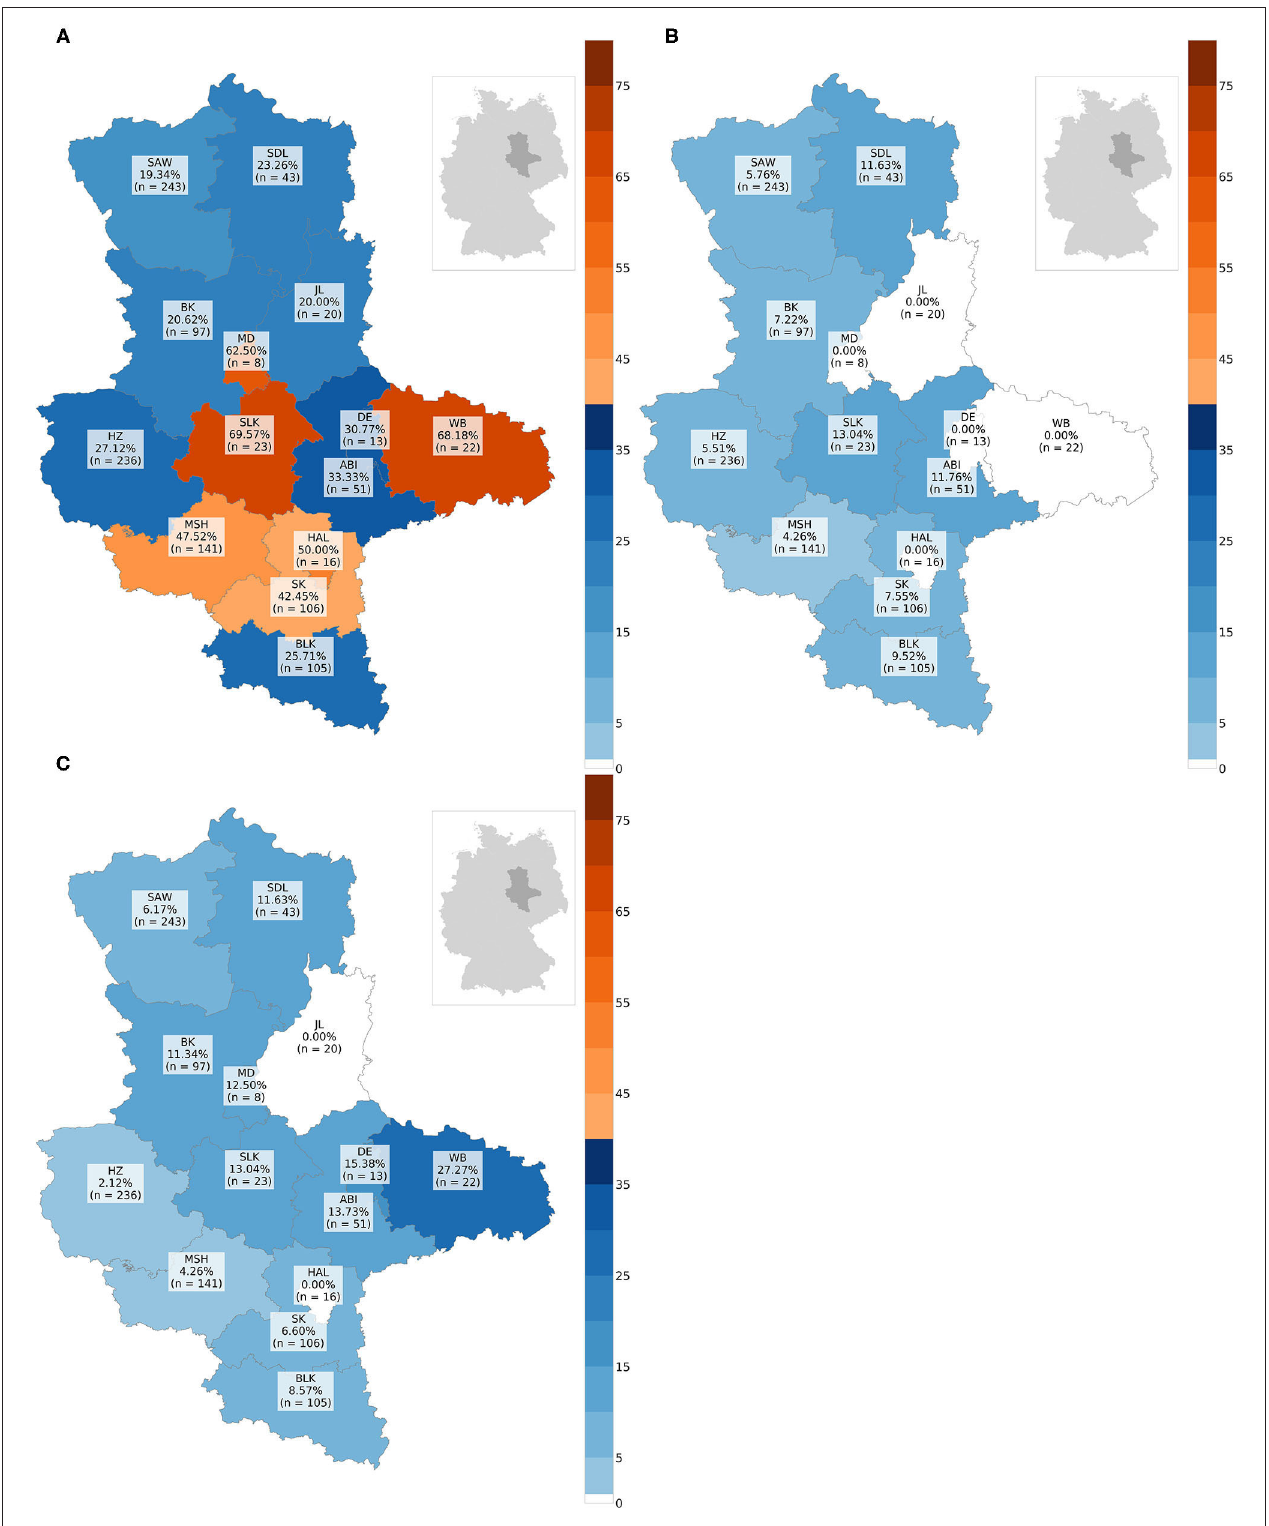
FIGURE 5 | Maps with prevalences in % of every administrative district: (A) prevalence of CDV, (B) prevalence of CPV-2, (C) prevalence of FoxCV. Number of animals sent in ( n ); ABI, Landkreis Anhalt-Bitterfeld; BK, Landkreis Boerde; BLK, Burgenlandkreis; DE, Dessau-Rosslau; HAL, Halle (Saale); HZ, Landkreis Harz; JL, Landkreis Jerichower-Land; MD, Magdeburg; MSH, Landkreis Mansfeld-Suedharz; SAW, Altmarkkreis Salzwedel; SDL, Landkreis Stendal; SK, Landkreis Saalekreis; SLK, Salzlandkreis; WB, Landkreis Wittenberg.